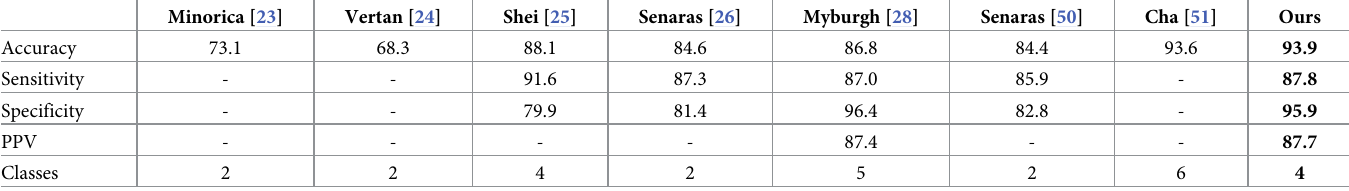
Table 3. Comparison of previous works and the proposed